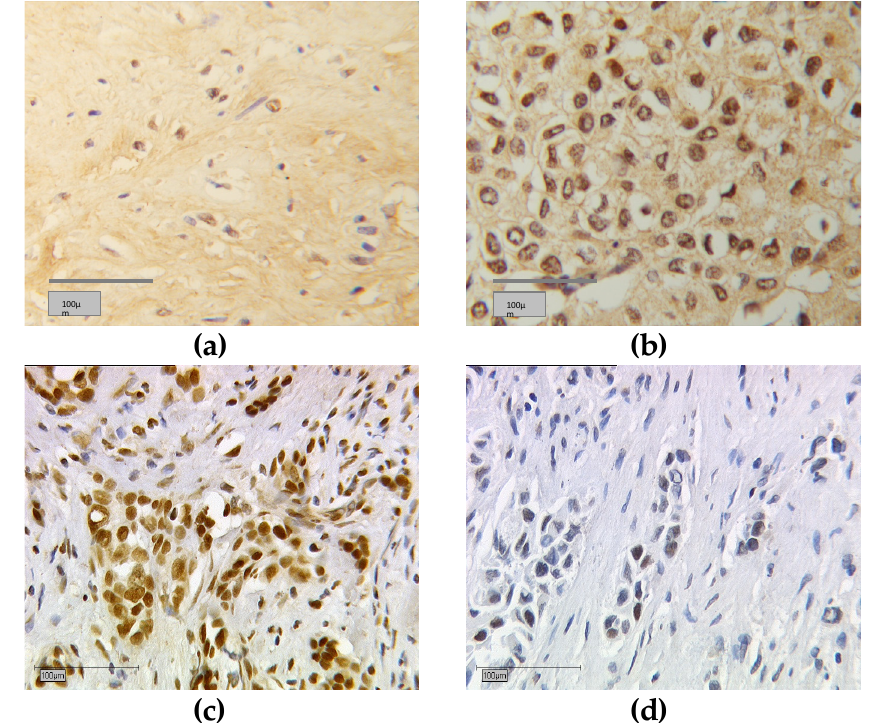
Figure 2. Immunohistochemical staining of retinoid X receptor (RXR). Immunohistochemical staining of RXRα in human breast cancer samples is illustrated in ( a – d ): ( a ) positive cytoplasmic RXRα expression only, ( b ) positive nuclear and cytoplasmic RXRα expression with a nucleo-cytoplasmic IRS ratio of 8:4, ( c ) positive nuclear RXRα expression only, ( d ) negative nuclear and cytoplasmic RXRα expression; ( a – d ) show 25× (scale bar = 100 μm) magnification.